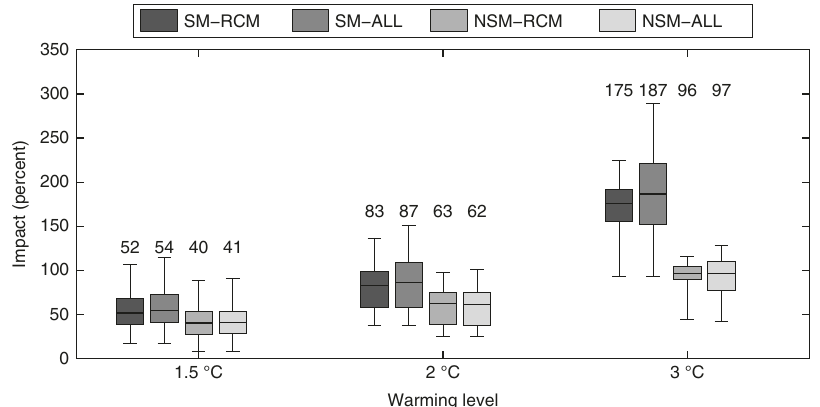
Fig. 3 Burned area changes in Mediterranean Europe with the stationary and the non-stationary models. Burned area changes (in %) are shown for each warming level considering the stationary model SM (i.e., using Eq. 3) and the non-stationary model NSM (i.e., using Eq. 4). Boxplots show the uncertainty from the ensemble of RCM projections (SM-RCM or NSM-RCM) and accounting for both RCM and regression model uncertainties (1000 bootstrap replications × the ensemble of RCMs; SM-ALL or NSM-ALL). The median is shown as a solid line, the box indicates the 25 – 75 percentile range, while the whiskers show the 2.5 – 97.5 percentile range. The numbers above the boxes indicate the median